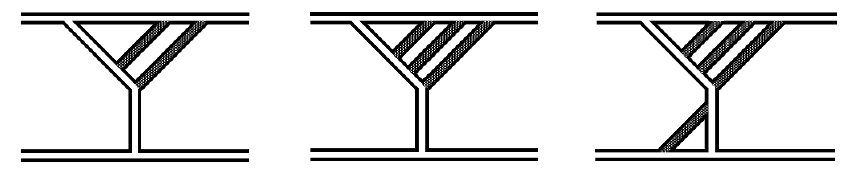
Figure 13 . Di(cid:11)erent possible ways of adding a soft line between the propagators with nearly pinching poles, which do not change the size of the rung. The momentum and a and r convention is the same as in (cid:12)gure